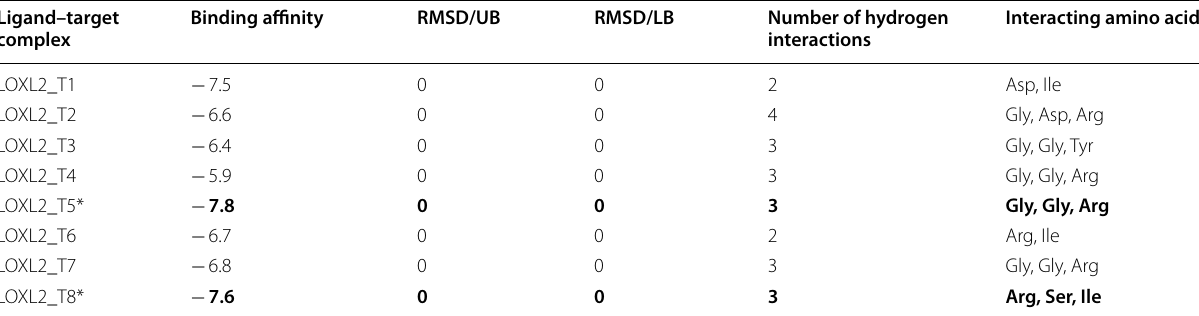
*Bold highlighted values are best-fit docked complexes based on the binding affinity values